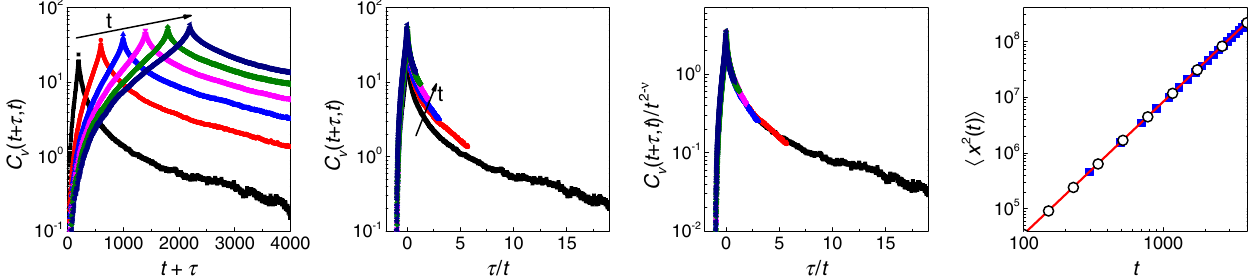
FIG. 1 (color online). Computation of the diffusion exponent and coefficient for cold atoms in optical lattices from the correlation function using the scaling Green-Kubo formula Eq. (9). (a) Correlation function as a function of the total time t þ τ for different values of t . (b) Correlation function plotted as a function of τ =t . (c) After rescaling by t ν − 2 with ν ¼ 2 . 37 . (d) Mean-square displacement obtained by integrating over the rescaled correlation function ϕ ð s Þ (empty circles) compared to the analytical result Eqs. (31) and (32) (red line) and the mean-square displacement obtained directly from the Langevin simulation (blue squares). From the rescaling and integration procedure, we obtain ν ≃ 2 . 37 and D ν ≃ 0 . 321 , which agrees well with the asymptotic analytical results ν ¼ 2 . 37 and ¼ 1 . 20 [see Eq. (22)], with 10 6 trajectories and 2 . 5 × 10 5 D ν ¼ 0 . 323 . The parameters for the simulation are D ¼ 3 . 25 , γ ¼ 5 . 10 , and v c integration steps per